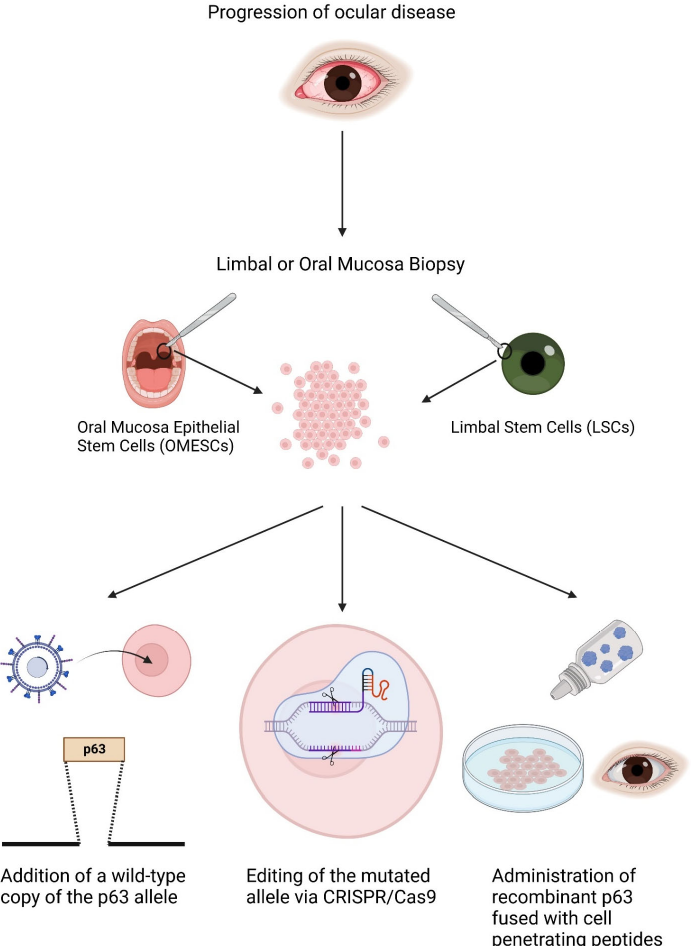
Figure 4. Innovative and future strategies for the treatment of the ocular defects in patients with EEC syndrome. New strategies have been suggested as a way to restore limbal stem cell functionality including (i) the addition of a wild-type copy of the p63 allele into the patient’s own cells by means of viral gene transfer agents; (ii) p63 mutated allele gene editing by means of CRISPR/Cas 9; and (iii) the administration of eyedrops containing recombinant p63 fused with a cell penetrating peptide. Abbre- viations: CRISPR/Cas 9: Clustered Regularly Interspaced Short Palindromic Repeats/Associated Protein 9. Created with BioRender.com. FIGURES AND